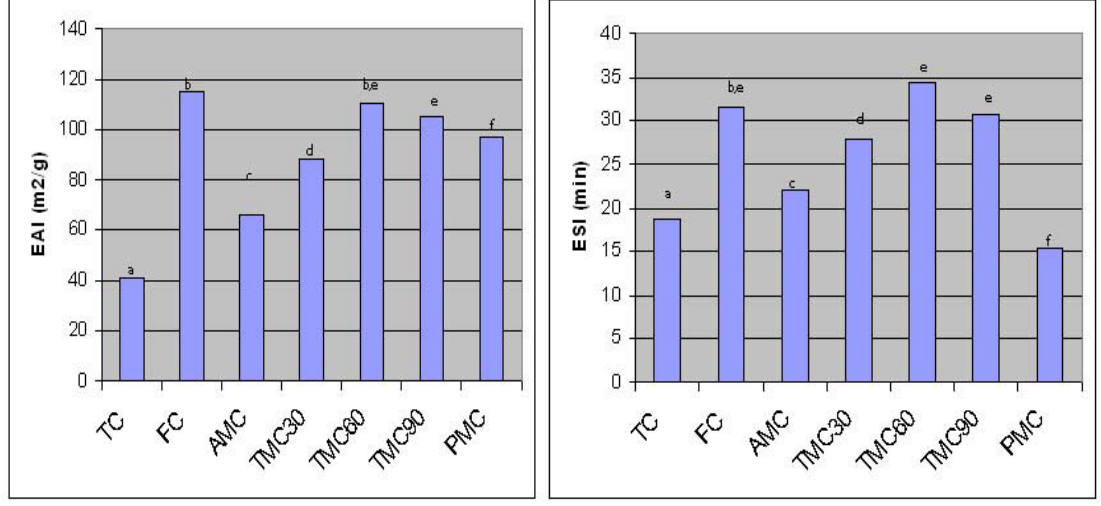
Figure 3. Emulsifying properties (EAI and ESI) of traditional and enzyme-modified concentrates* TC-traditional soy protein concentrate; FC-functional concentrate; TMC30, TMC60 and TMC90 – samples modified with trypsin during 30, 60 and 90 minutes; PMC – samples modified with pepsin. *Means with different letters are significantly